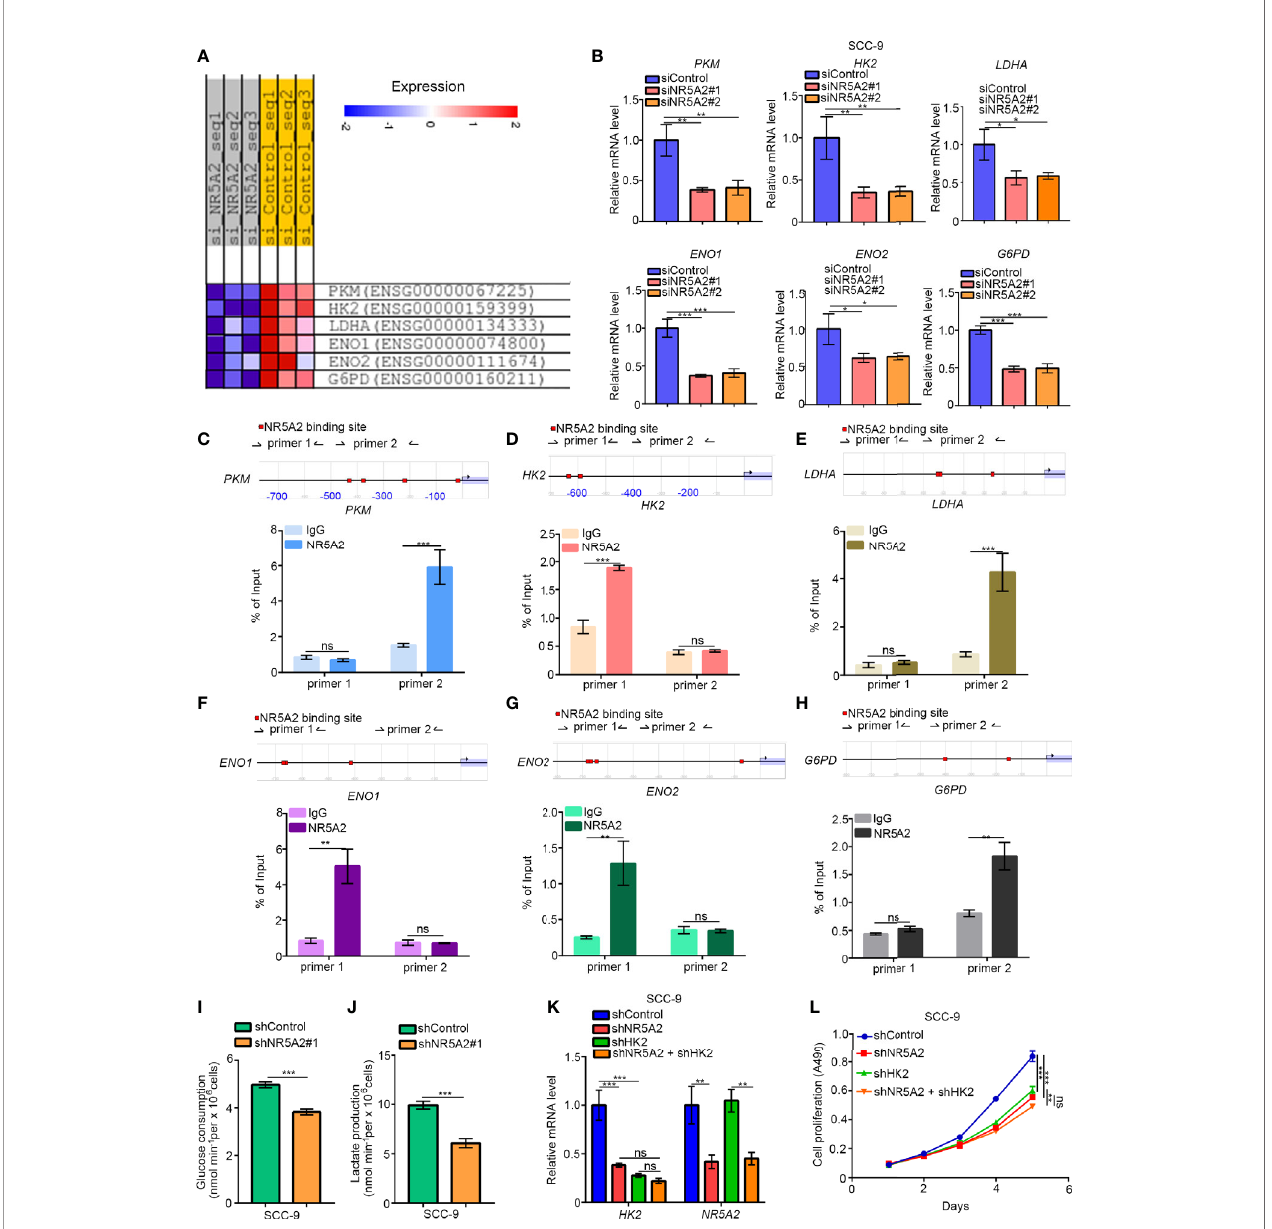
FIGURE 7 | NR5A2 regulates glycolysis independently of p53. (A) , heatmap to show the genes related to glycolysis after knocking down of NR5A2 or not in FaDu cells. (B) , SCC-9 cells was infected with the speci fi c siRNAs. After 48 h, cells were subjected to the RT-qPCR analysis. Data are shown as means ± SD (n = 3). *P < 0.05; **P < 0.01; ***P < 0.001. (C – H) , the ChIP-qPCR analysis of SCC-9 cells. Data are shown as means ± SD (n = 3). n.s, not signi fi cant; **P < 0.01; ***P < 0.001. (I, J) , SCC-9 cells were infected with indicated shRNAs. After 48 h, the spent medium of cells was changed with the fresh medium for another 24 h. The spent medium was collected for the measurement of glucose consumption (I) and lactate production (J) . The data shown are the mean values ± SD from three replicates. ***P < 0.001. (K, L) , SCC-9 cells were infected with indicated shRNAs. After 48 h, cells were harvested for RT-qPCR analysis and MTS assay. Data are shown as means ± SD (n = 3). n.s, not signi fi cant; **P < 0.01; ***P <